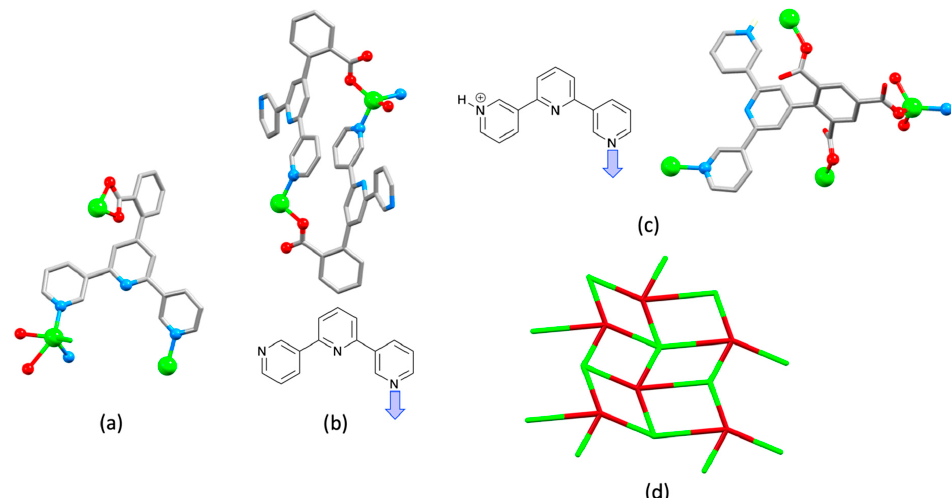
Figure 42. ( a ) The building block in [ZnCl( 63 )] n · n H 2 O (CSD refcode MICTAW); compare this with Figure 41b. ( b ) Detail of one loop in the 1D-chain in [Zn( 63 ) 2 ] n (refcode MICTEA) and the ligand conformation; one terminal pyridine ring is non-coordinated; compare with Figure 41d. ( c ) The building block in [Zn(H 64 )] n · 1.5 n H 2 O (refcode MUNDEH) and ligand conformation. ( d ) Part of the (4,4) net in [Zn(H 64 )] n · 1.5 n H 2 O with 4-connecting Zn nodes (green) and ligand nodes (red); the ligand node is defined as the centroid of the central pyridine ring.